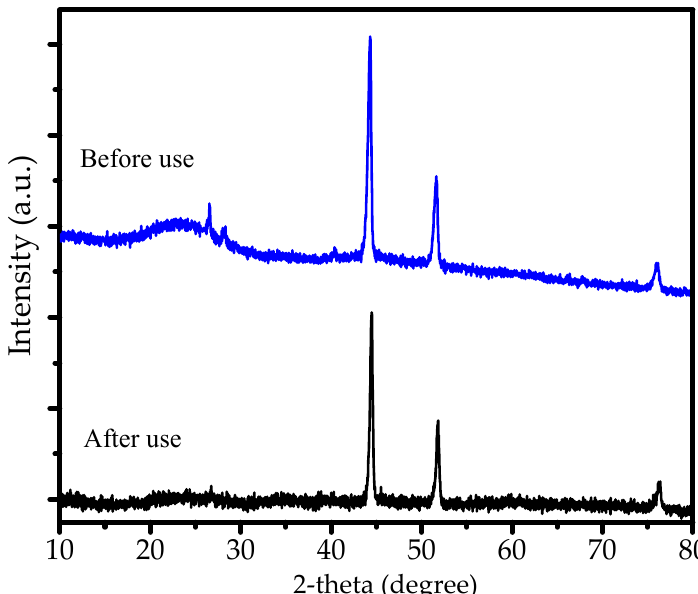
Figure 8. Comparison of XRD pattern of Ni/BC before and after use.